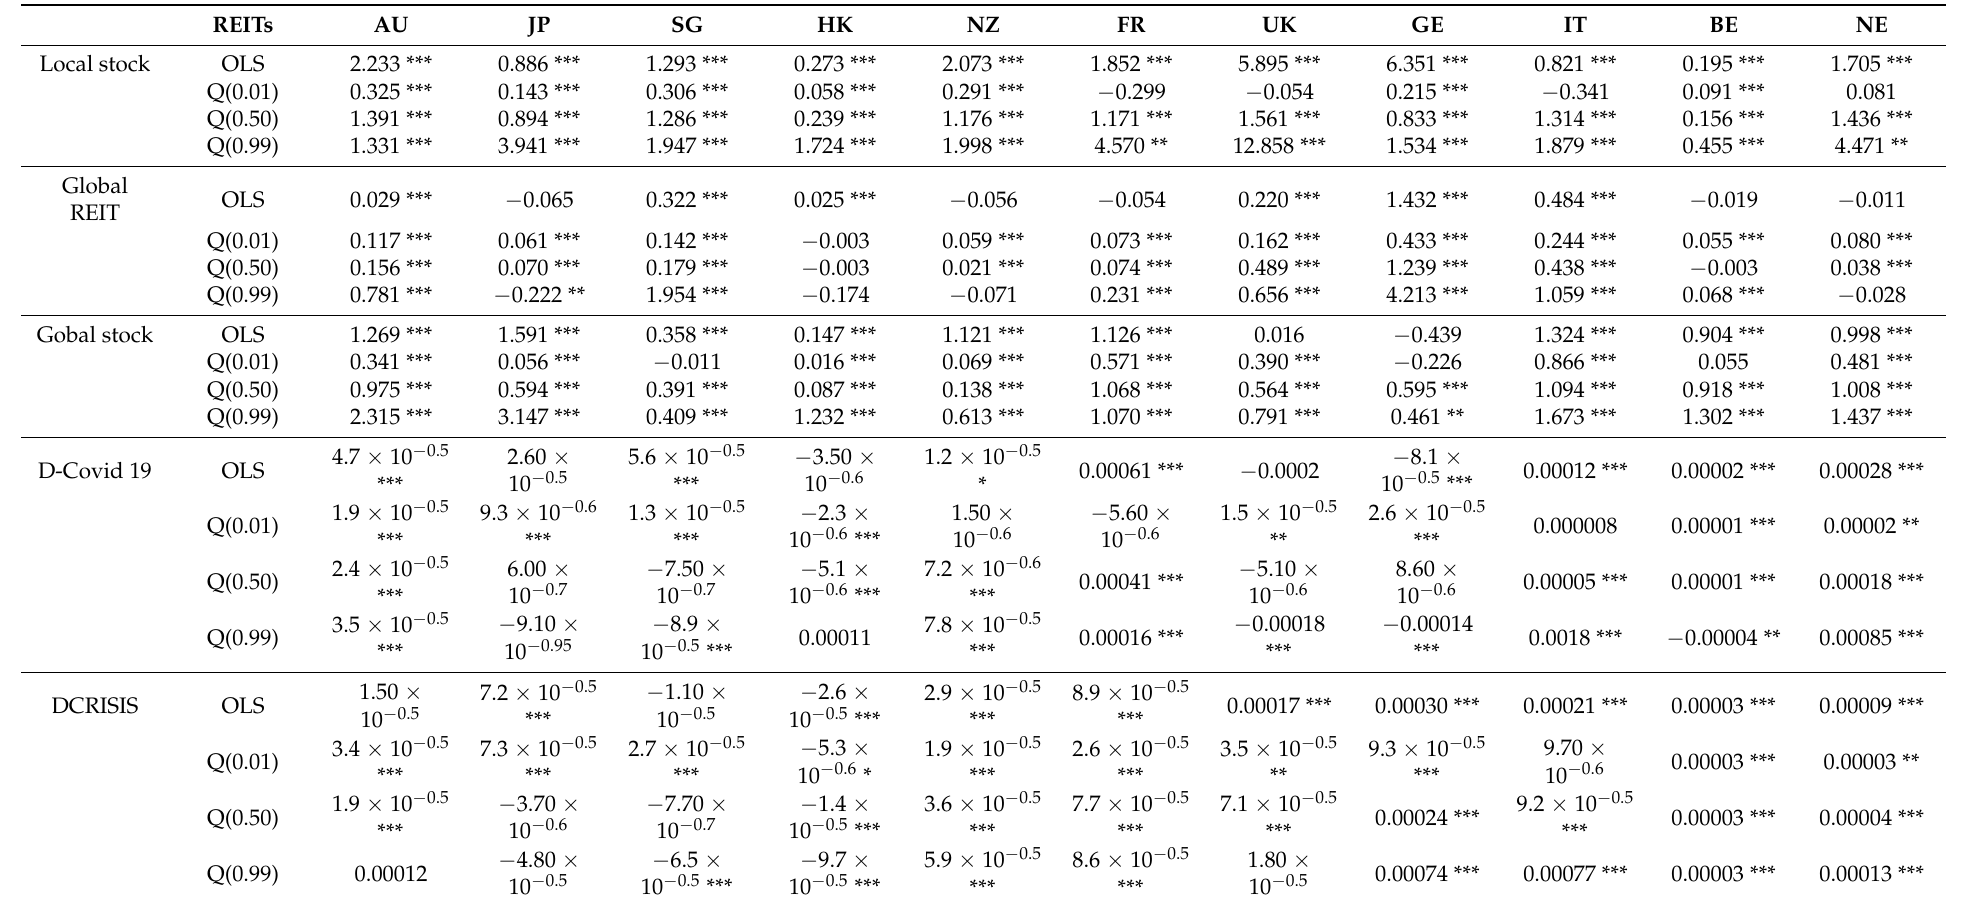
Table 2. Estimated results of the three-factor OLS and quantile regression models (with two crisis